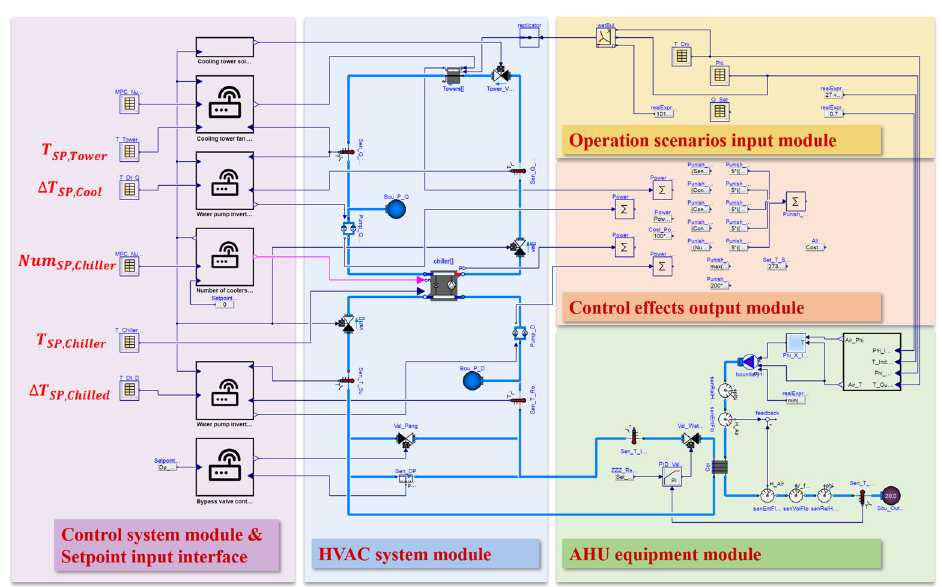
Figure 8. Diagram of the HVAC system model.